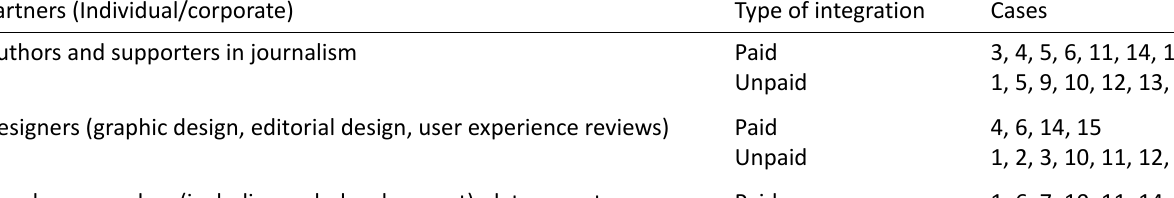
Table 2. Partners involved and type of integration. Partners